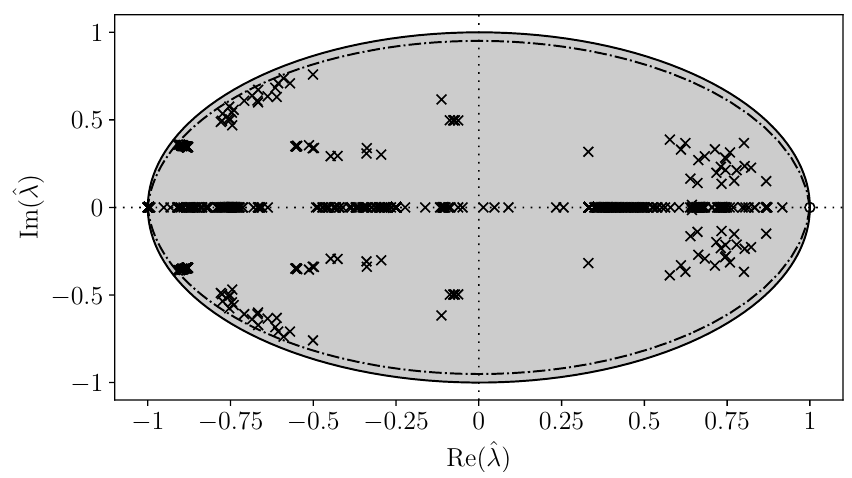
Figure 3. AIITS: Cayley transform image of the spectrum, σ = 2.